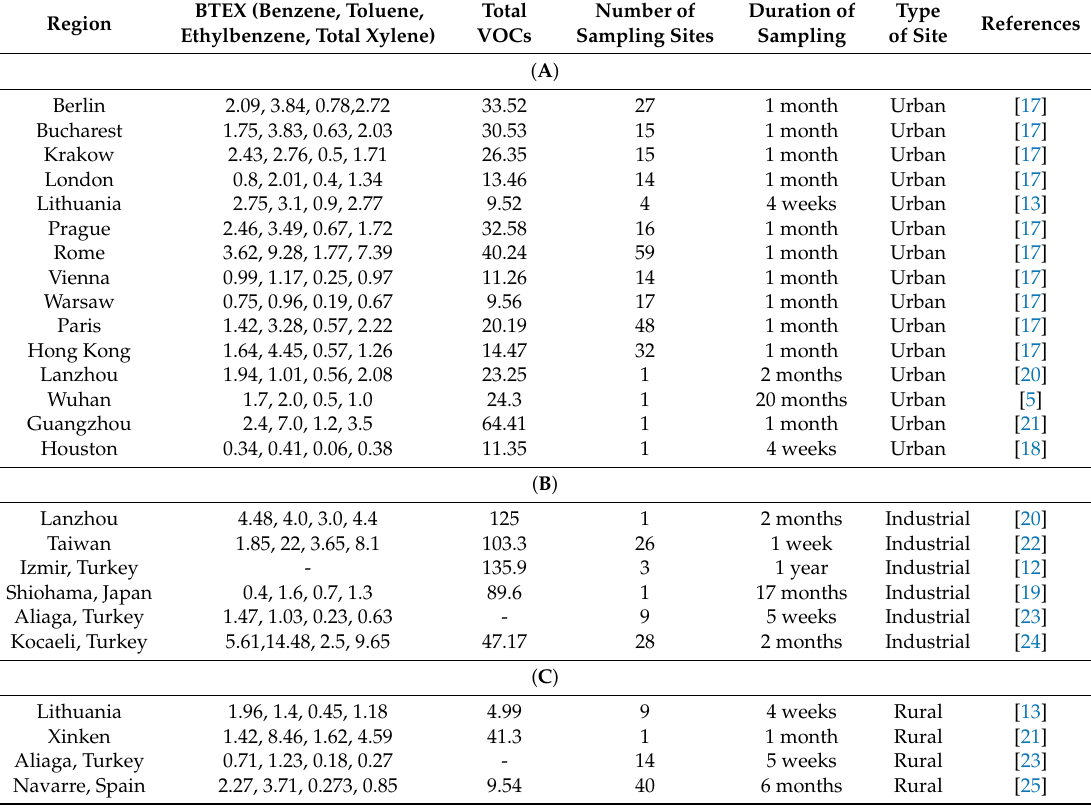
Table 4. ( A ) Measured Benzene, Toluene, Ethylbenzene, Xylene(BTEX) and total VOC concentrations (ppbv) in urban regions; ( B ) Measured BTEX and total VOC concentrations (ppbv) in industrial regions; ( C ) Measured BTEX and total VOC concentrations (ppbv) in rural regions. BTEX (Benzene, Toluene, Region Ethylbenzene, Total